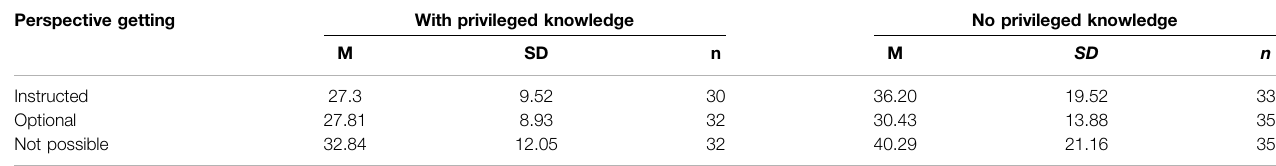
TABLE 1 | Means and standard deviations for accuracy scores (absolute mean difference score between predicted and actual price estimates) in Study